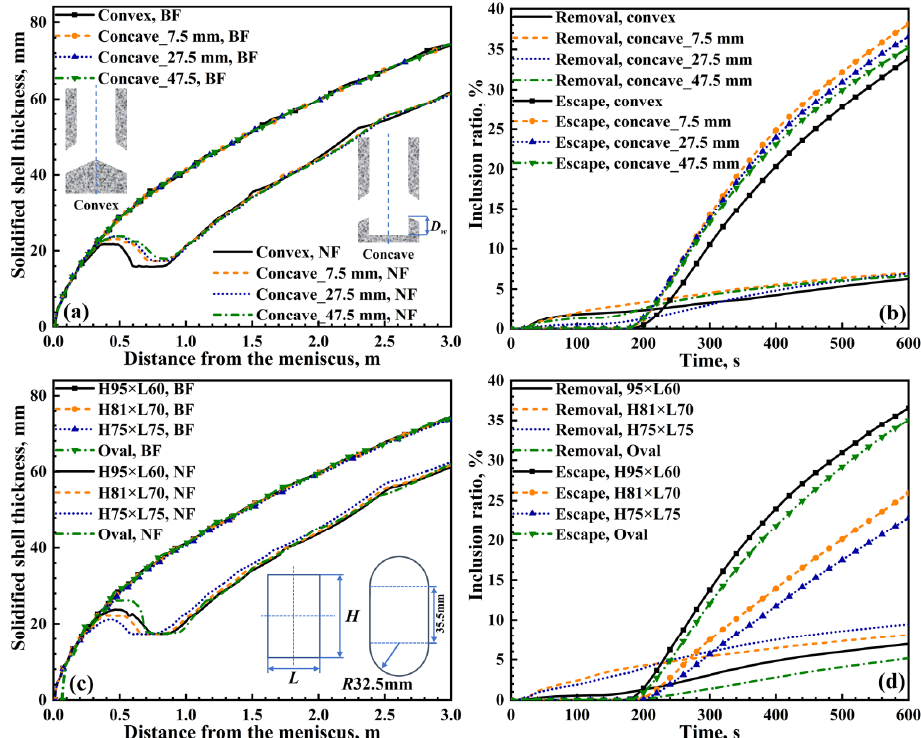
Figure 6. Solidified shell distributions along the casting direction ( a , c ) and the predicted inclusion ratios of removal and escape ( b , d ) with different SEN bottoms and port shapes.